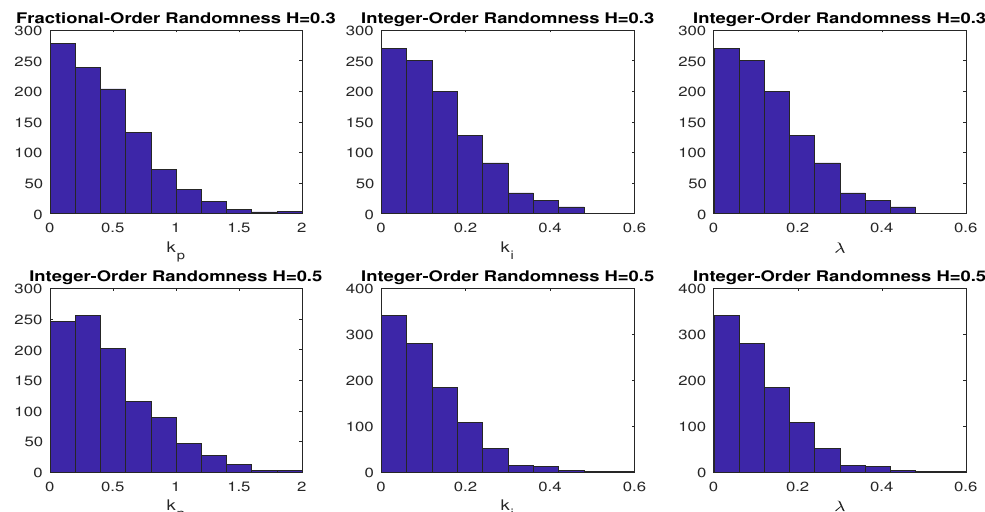
Figure 7. Fractional order randomness employed for the SOC controller with H = 0.3, 0.5.